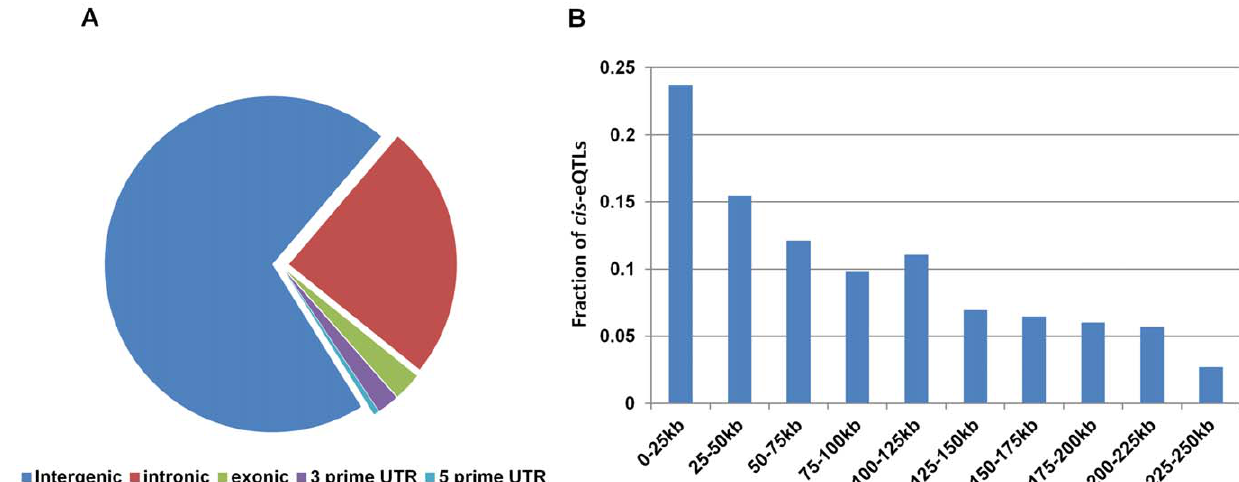
Figure 2. Distribution of lincRNA cis -eQTLs with respect to different transcripts. (A) The majority of the lincRNA cis -eQTLs are located within the non-coding part of the genome and less than 6% of lincRNA cis -eQTLs are located within mRNA. (B) Distribution of lincRNA cis -eQTLs with respect to distance to the lincRNA transcripts. The x-axis displays the 250 kb window used for cis -eQTL mapping and the y-axis displays the fraction of lincRNA cis -eQTLs located within this window.